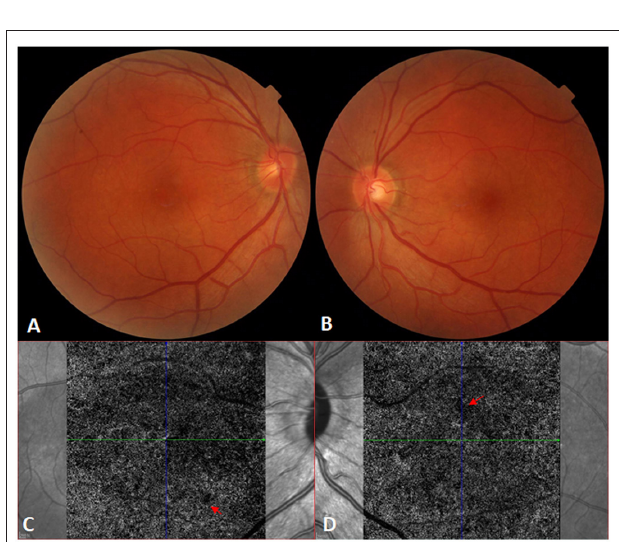
FIGURE 3 | Recovery from Vogt-Koyanagi-Harada disease. (A,B) The fundus appears normal in the right and left eyes, respectively, after systemic corticosteroid therapy. (C,D) Optical coherence tomography angiography still shows bilateral dotted hypoperfusion of the choroidal capillaries [red arrows; (C) : right eye; (D) : left eye] 6 months after the onset of Vogt-Koyanagi-Harada